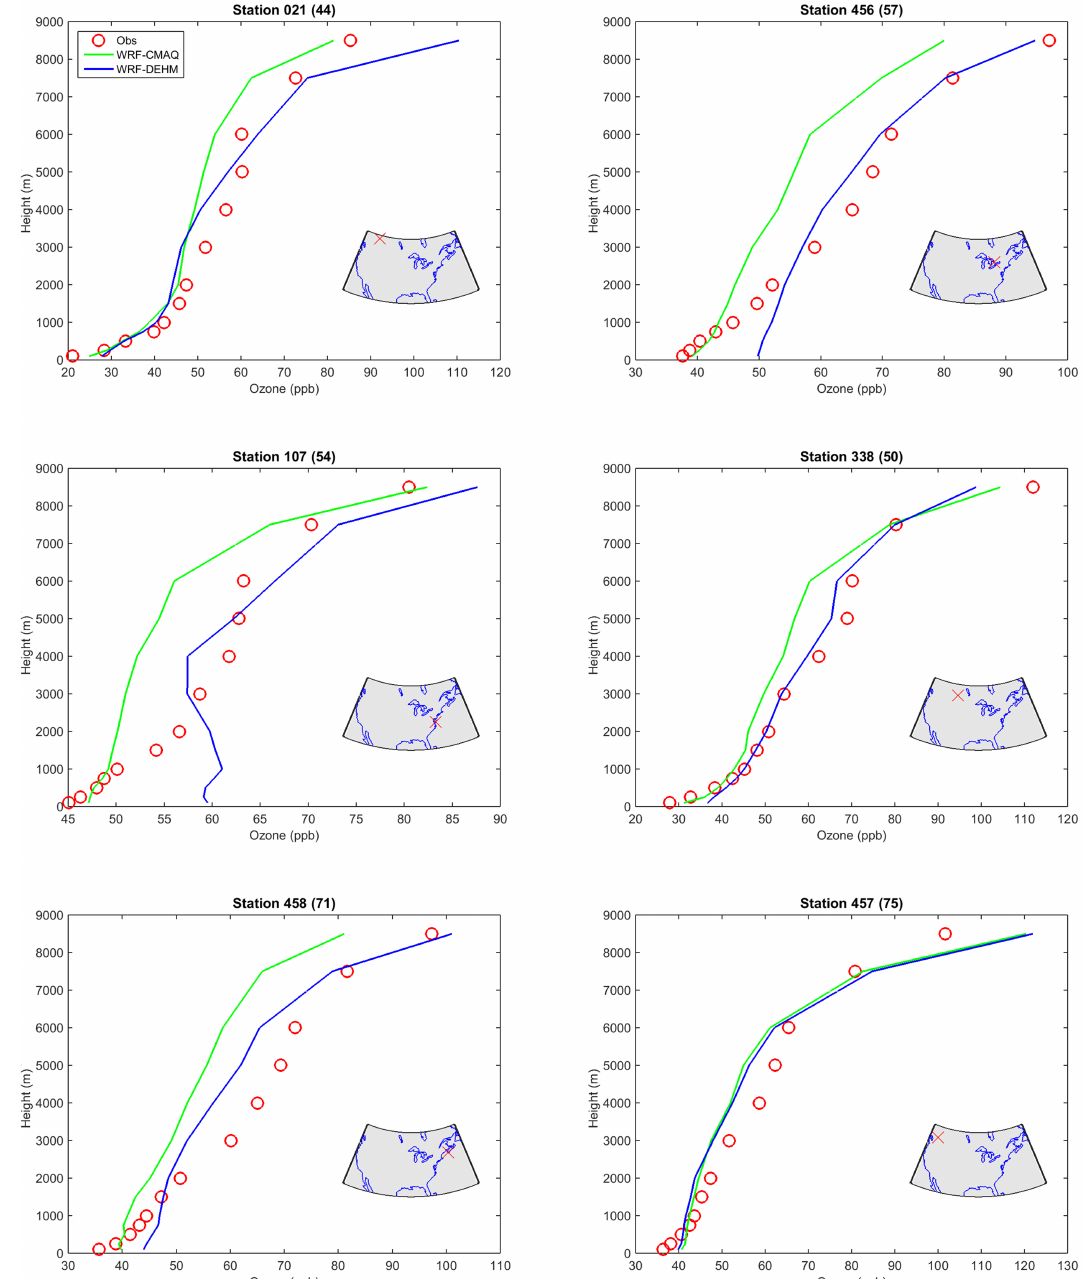
Figure 20. As in Fig. 19 but for North